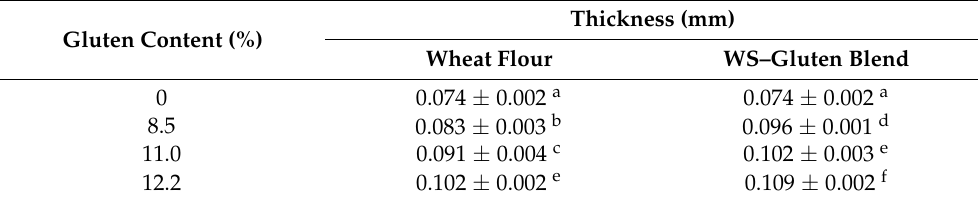
Table 6. Thicknesses for the films of pure WS, wheat flours, and WS–gluten blends with different protein contents (8.5%, 11.0%, and